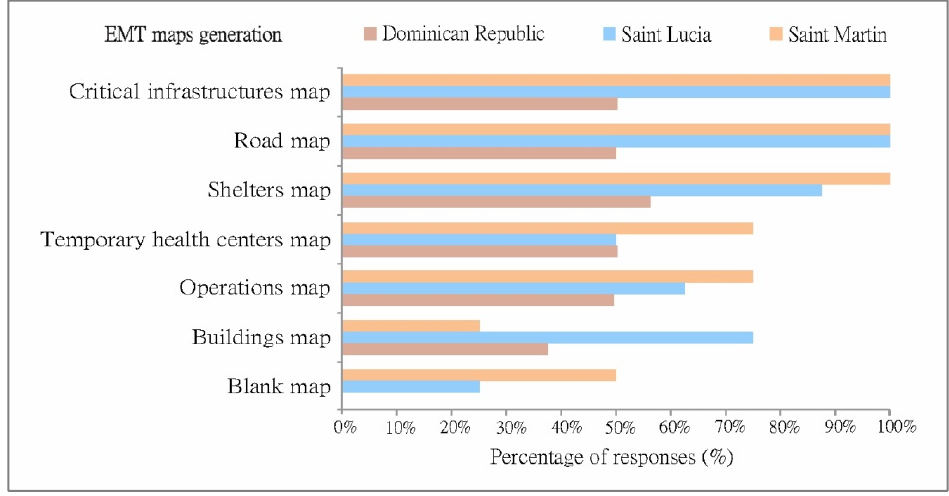
Figure 10. Type of maps generated in EMT operations (Q31).